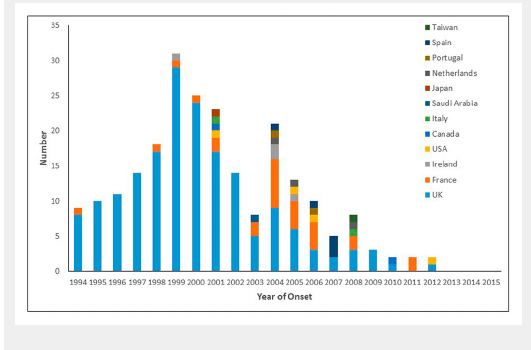
Variant Creutzfeldt Jakob disease cases by year and country: 1994-2015 (n =